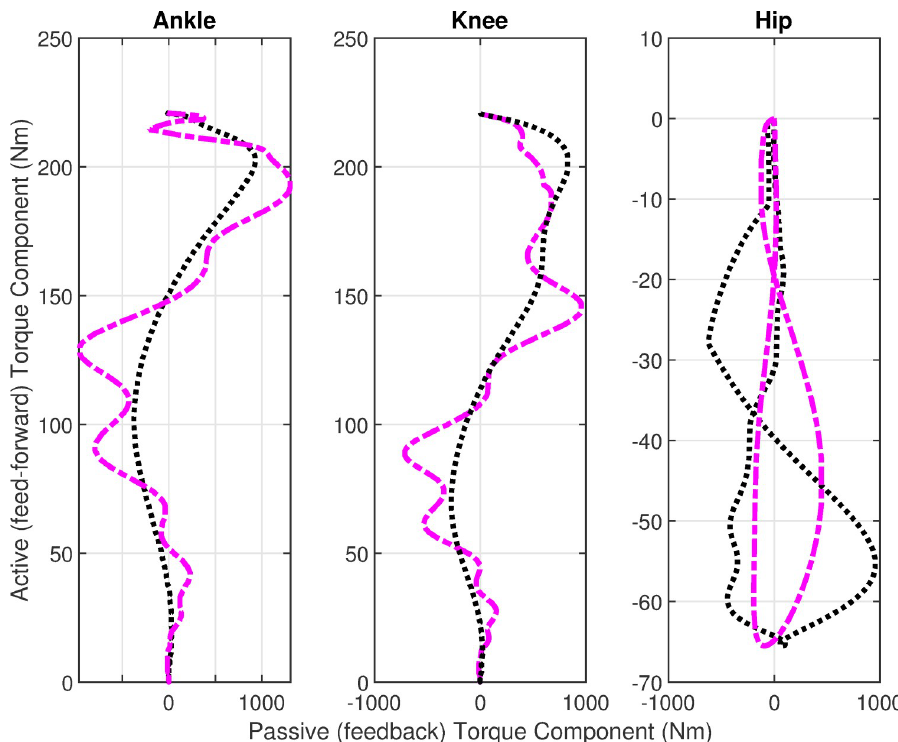
Fig 7. Active vs passive profiles. Black lines show the simulations without delays and purple lines show the simulations with delays.